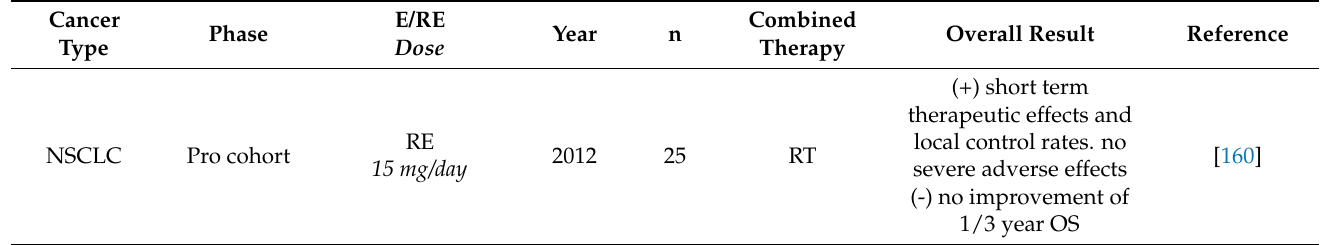
Table 3. A selection of clinical trials on RE combined with RT in